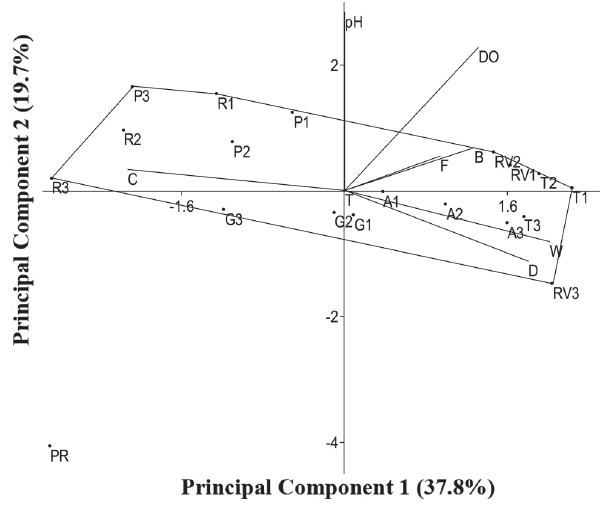
Fig. 1. Ordination resulted from principal components analysis, considering the structural habitat variables (width: